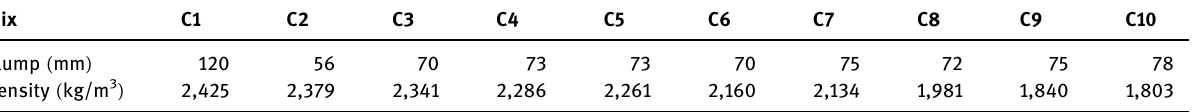
Table 8: Slump and densities of trail mixes